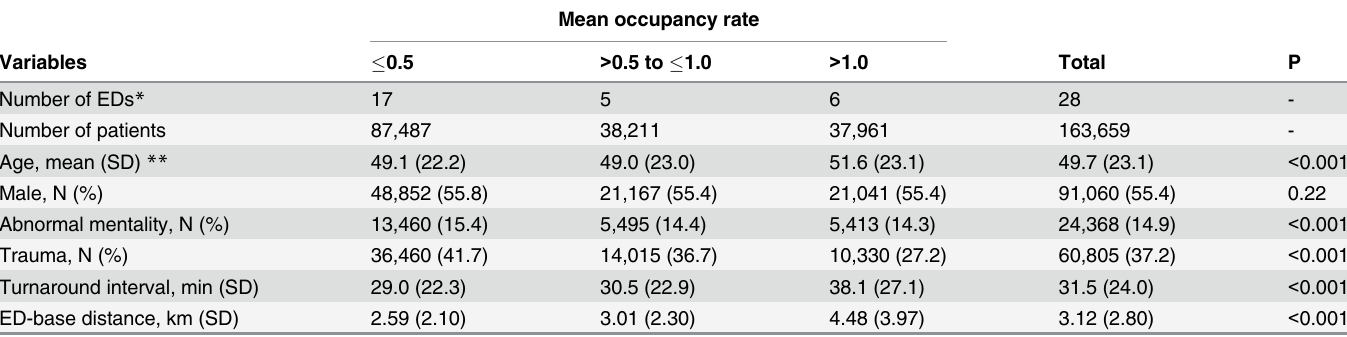
Mean occupancy rate